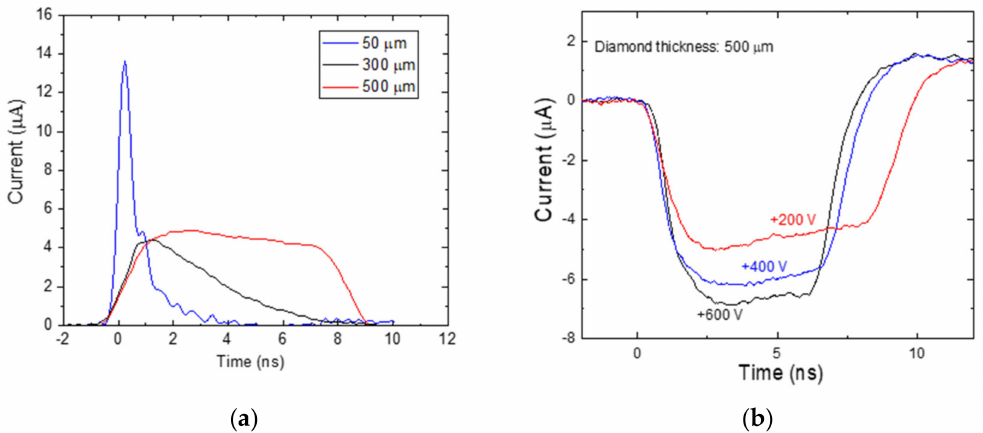
Figure 11. ( a ) Typical signals (current) from diamond detectors featured by different thicknesses measured by the transient current technique (TCT); ( b ) signals from diamond changing the bias applied to the detector.